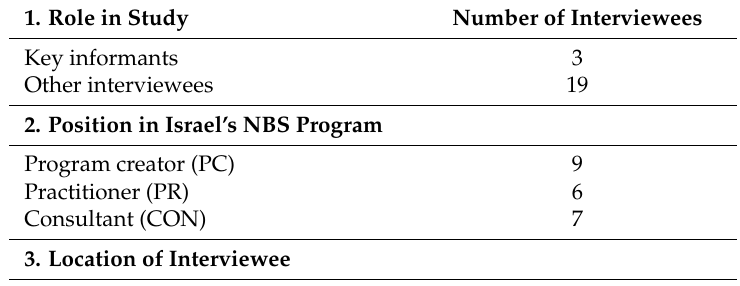
Table 1. General characteristics of Interviewees ( N = 22).